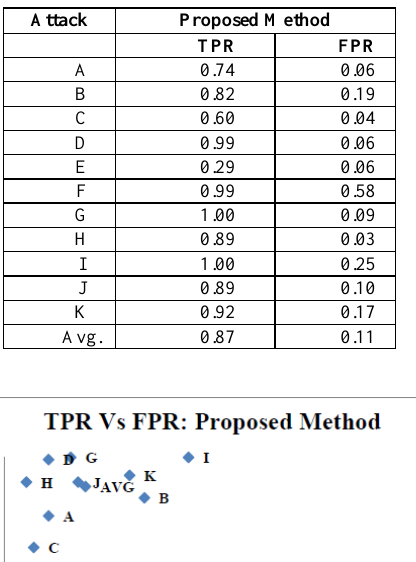
Table 8, TPR and FPR for Proposed Method.